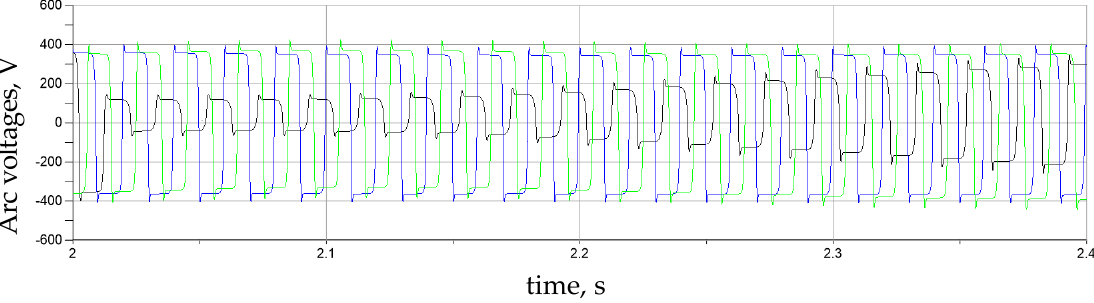
Figure 5. Voltage of arcs during perturbation in phase A: phase A, phase B, phase C.